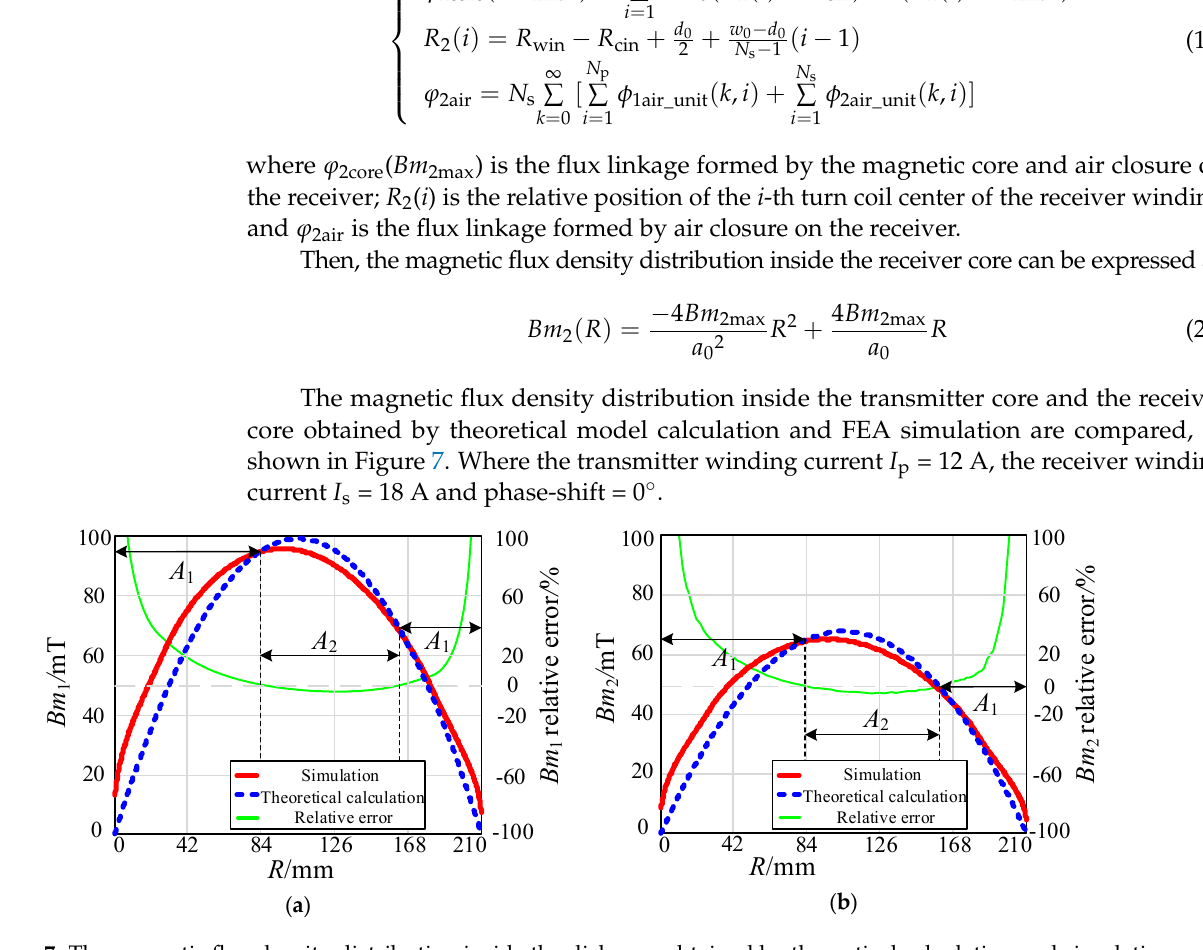
Figure 7. The magnetic flux density distribution inside the disk core obtained by theoretical calculation and simulation. ( a ) Transmitter core; ( b ) Receiver core.